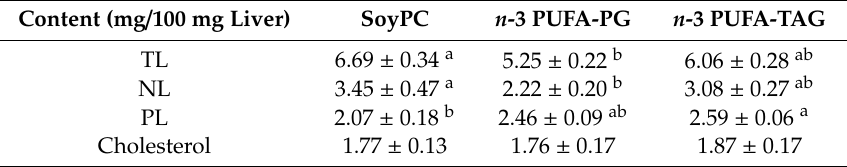
Table 5. Lipid and cholesterol contents in the liver of KK- A y mice fed experimental diets. Content (mg / 100 mg Liver) SoyPC